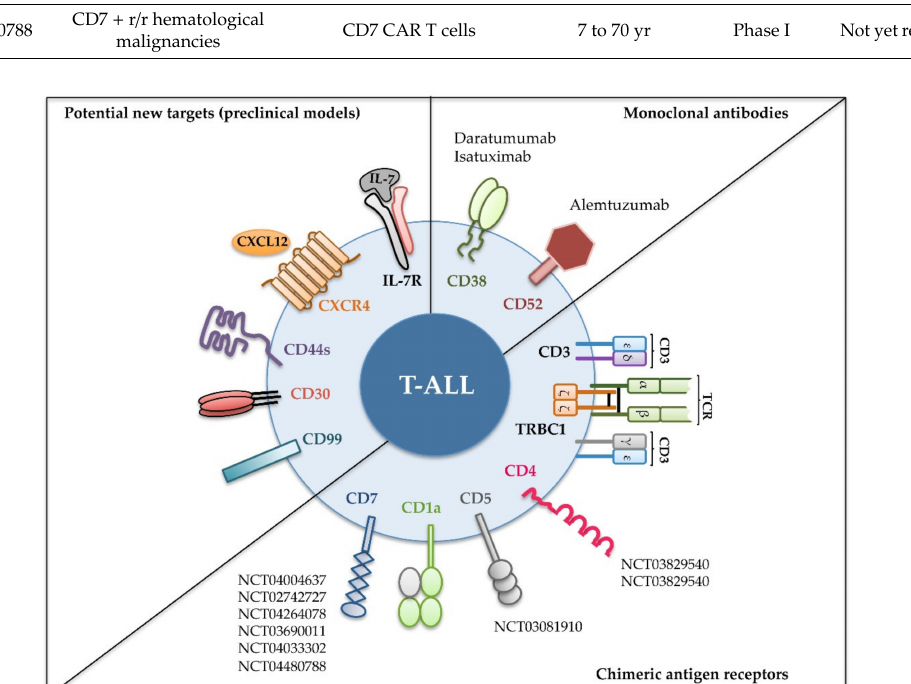
Figure2. RecentimmunotherapeuticinterventionsforT-ALL.Di ff erentstrategiestargetingtheindicated cell surface molecules expressed on leukemic cells have been designed for T-ALL treatment. Monoclonal antibodies have been tested in the clinic against relapsed and / or refractory T-ALL (upper right); chimeric antigenreceptorswereassayedeitherinpreclinicalorinclinicalsettings(lowerright); andnewmolecules have revealed their potential as promising targets in preclinical models (left). Identifiers [The National Clinical Trial (NCT) number] of clinical trials in progress including T-ALL patients are shown